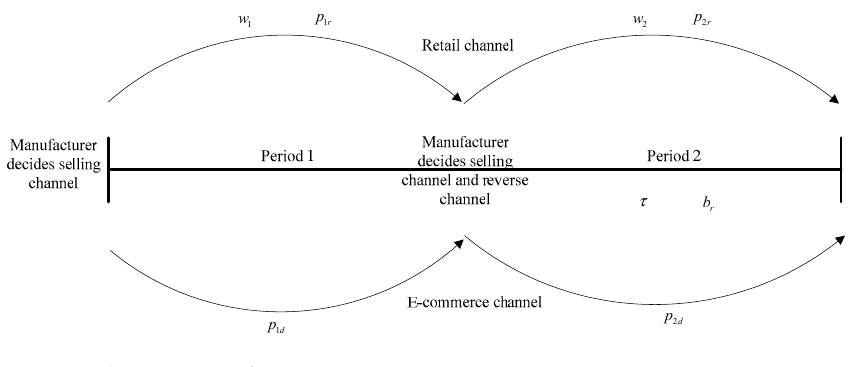
Figure 1. The sequence of events.